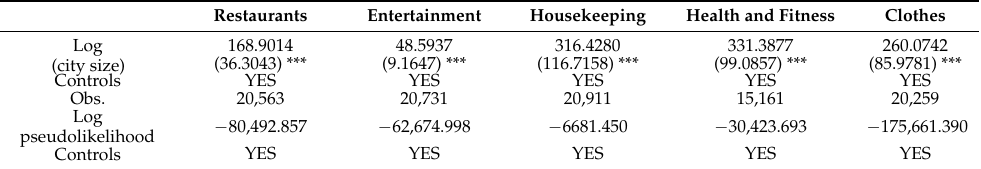
Table 4. Tobit model estimates on the effect of city size on household expenditures; control variables are